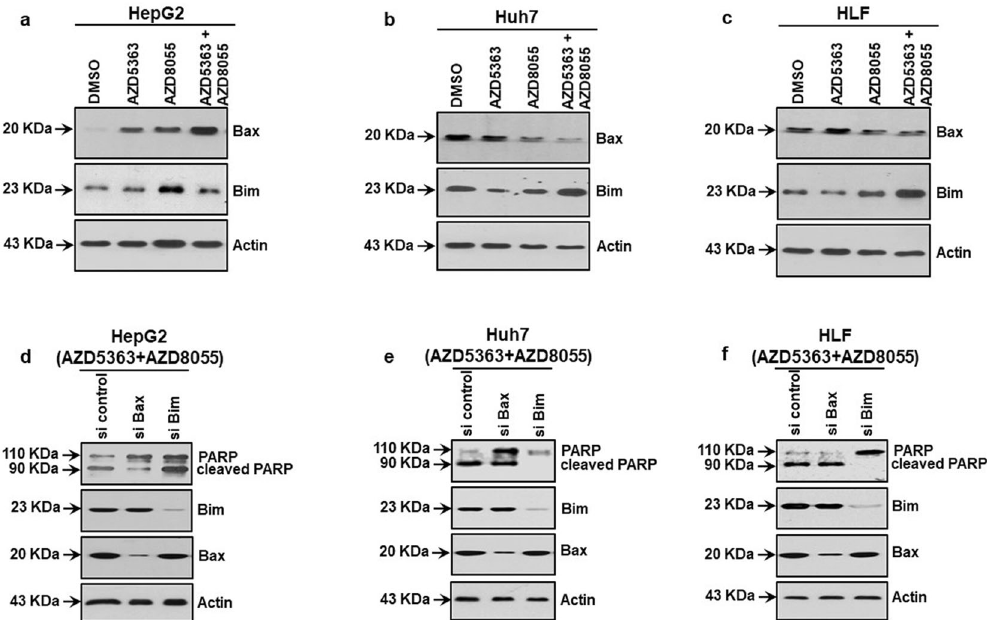
Fig. 3 Stimulation of pro-apoptotic protein in HCC cells following inhibitor treatment. Western blot analysis was performed from HCC cell lysates following treatment with individual or a combination of 5 µM AZD5363 and 100 nM AZD8055 for 48 h. The expression status of Bax and Bim in HepG2 ( a ), Huh7 ( b ), and HLF ( c ) cells are shown. Western blot analysis was performed from HCC cell lysates following treatment with a combination of 5 µM AZD5363 and 100 nM AZD8055 after knocking down of Bax or Bim using speci fi c siRNAs. The expression status of PARP, Bim and Bax in HepG2 ( d ), Huh7 ( e ), and HLF ( f ) cells are shown. Expression of actin in each lane was considered for comparison of protein load and illustrated by blots shown at the